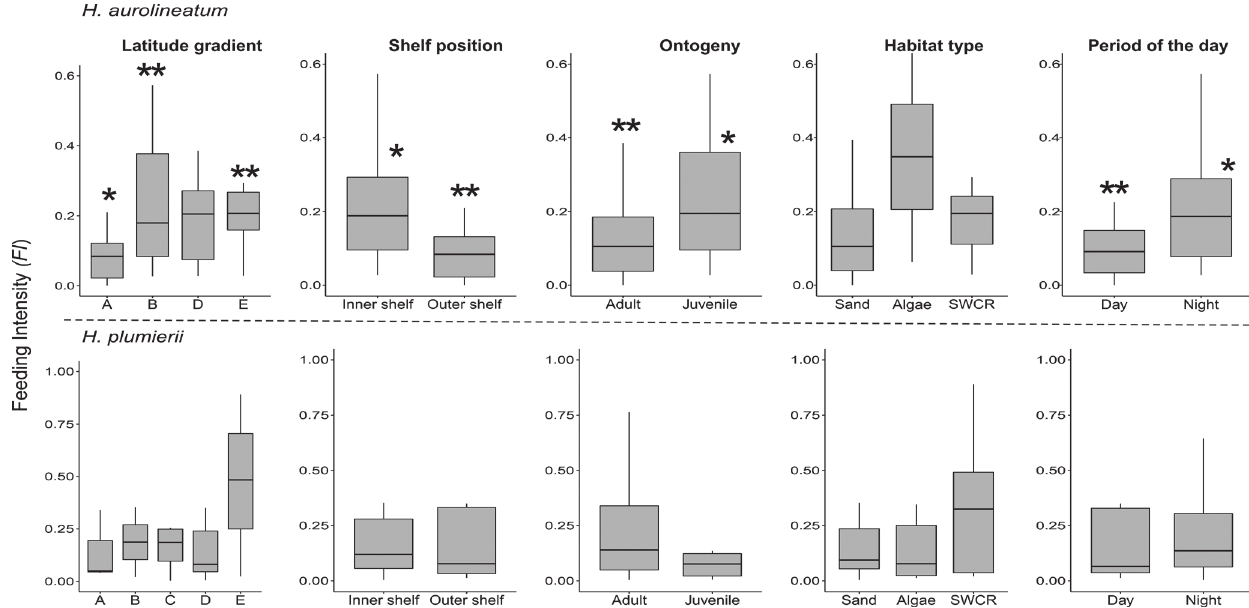
FIGURE 2 | Feeding intensity indicator (Fi) of Haemulon aurolineatum and H. plumierii in different habitats, latitude gradient, shelf position, ontogeny and period of the day. The black horizontal line and box represent the median value and the interquartile range, while the vertical lines represent the upper and lower limits. Outliers were not included in the plot. Different symbols (* and **) represent significant